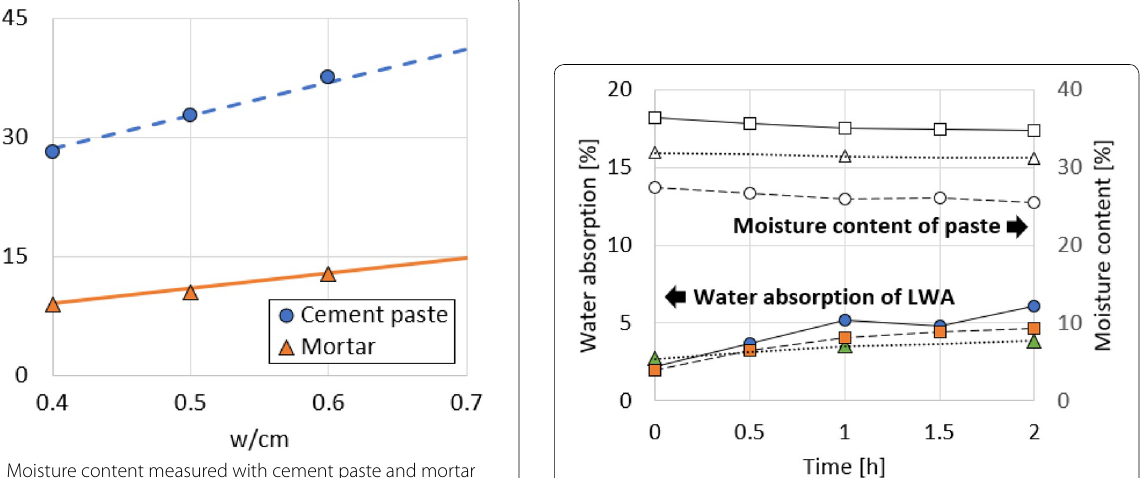
Fig. 3 Water absorption of LWA and moisture content of surrounding cement